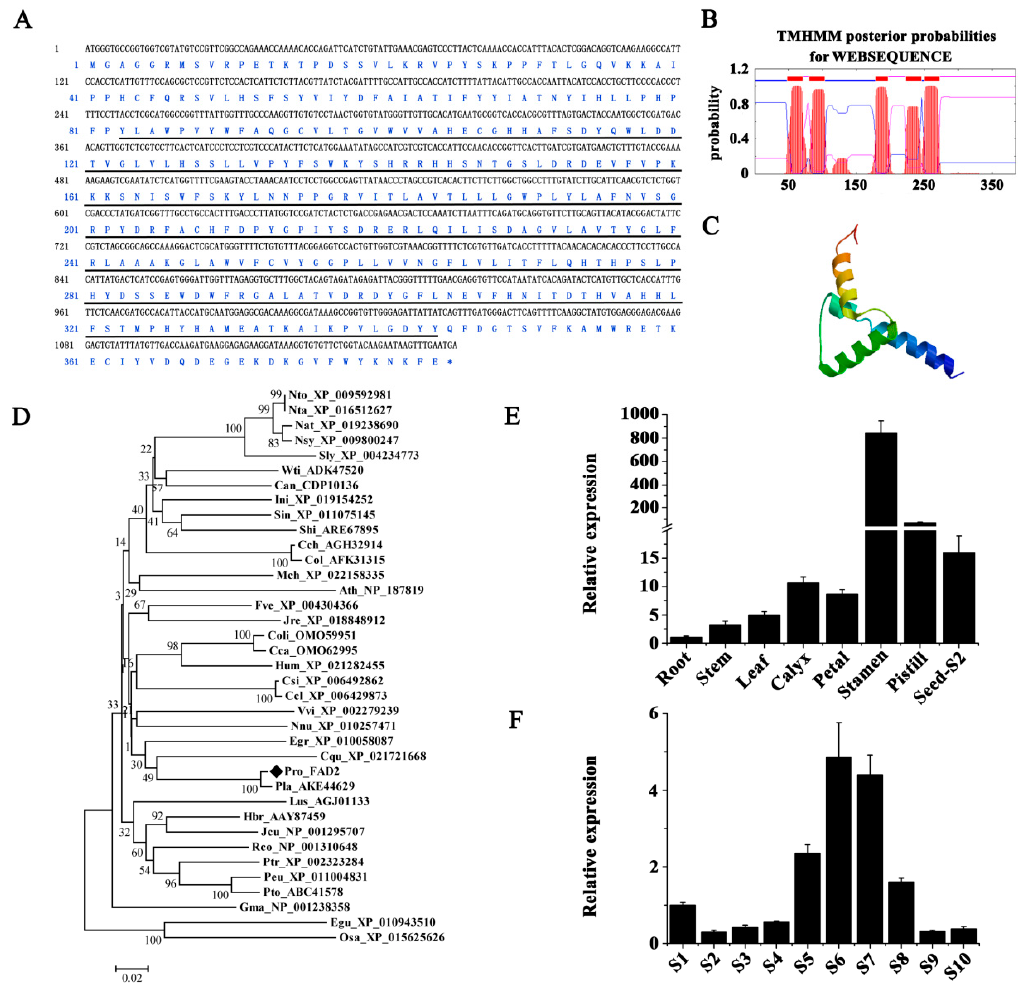
Figure 7. Identification, characterization, and expression analysis of PrFAD2 in P. rockii . ( A ) Nucleotide and deduced amino acid sequence of PrFAD2 . Solid lines indicate the conserved 1-acyl- sn -glycerol-3-phosphate acyltransferase-related domain. Prediction of the ( B ) transmembrane domains and ( C ) tertiary structure of Pr FAD2 protein. ( D ) Phylogenetic comparison of the FAD2 proteins in plants (refer to Table S6 for complete names of the plant species). ( E ) Tissue-specific expression of PrFAD2 . ( F ) PrFAD2 expression during P. rockii seed development. S1 to S10 indicate ten time points from 0 to 100 days at 10 days intervals. 18S–26S ITS was used as an internal control.